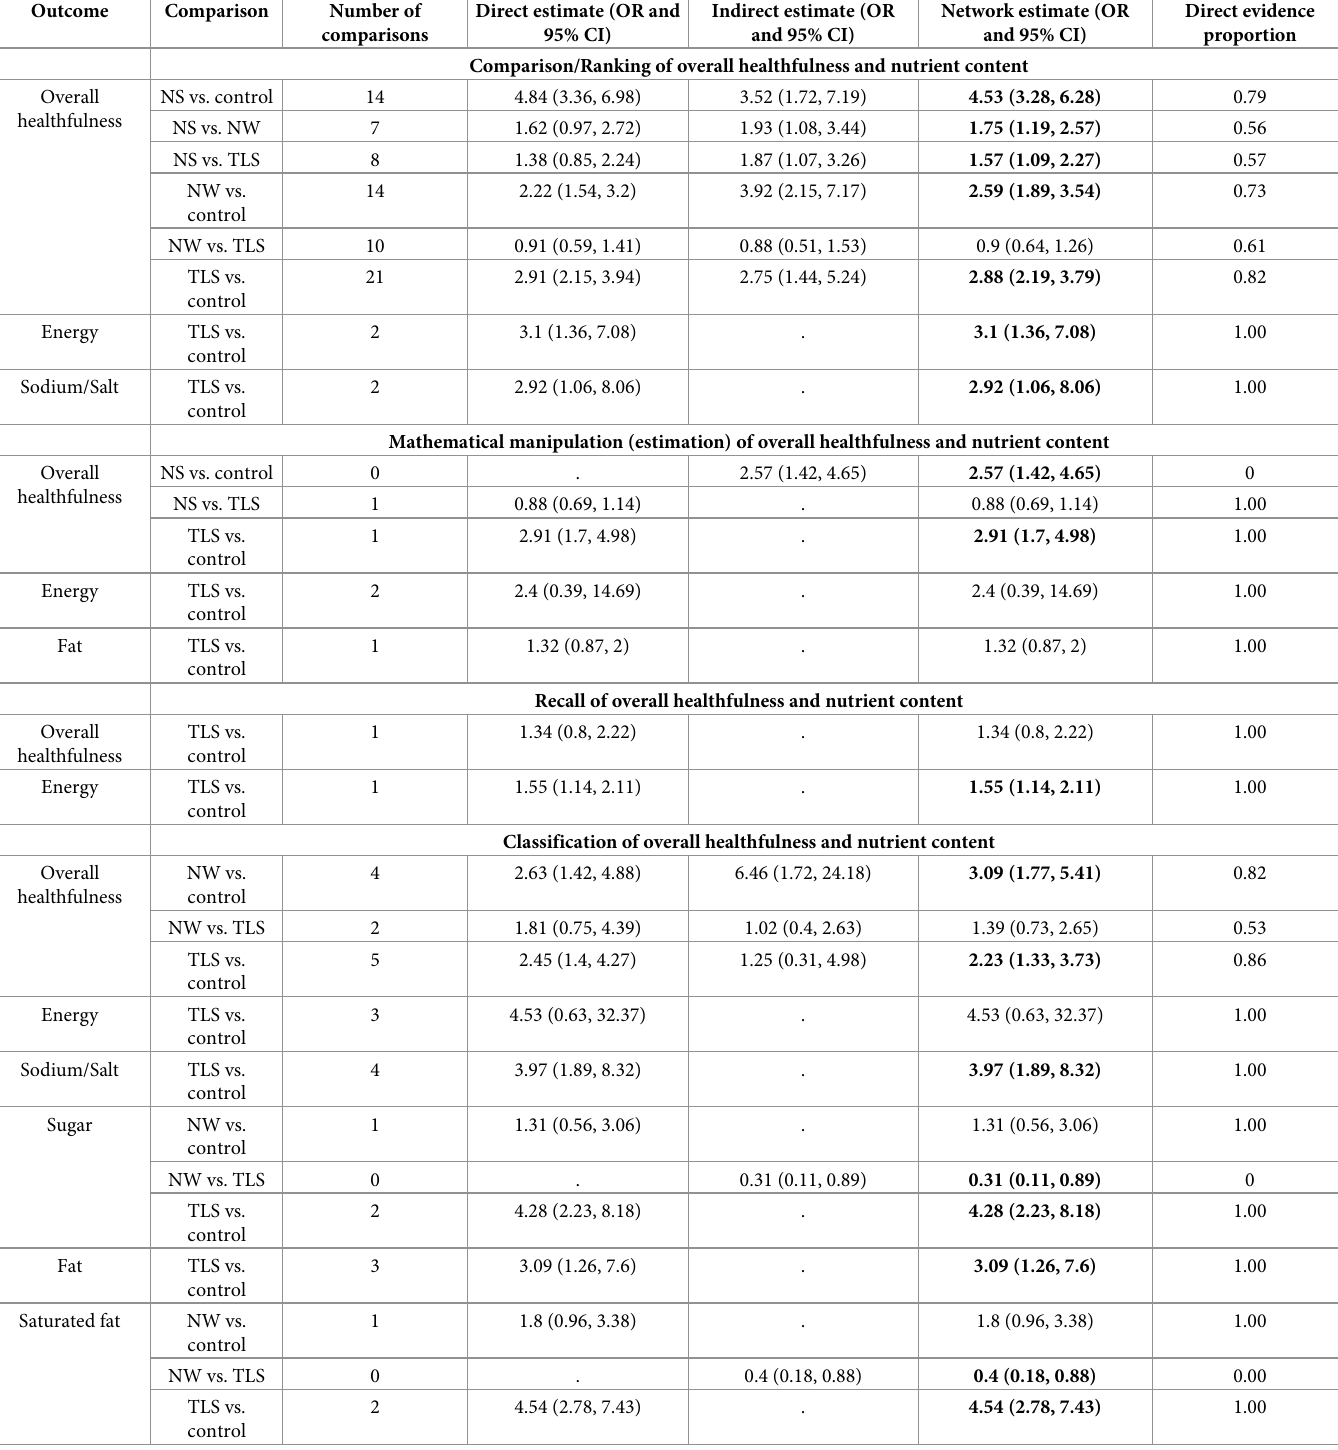
Table 3. The network effects of objective understanding of different label